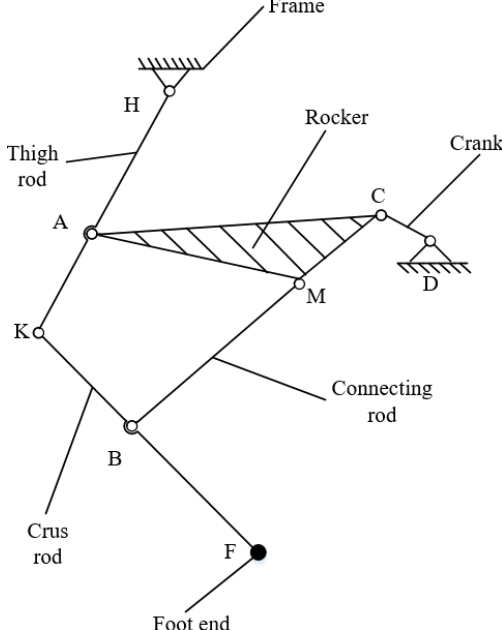
Figure 2. Structural diagram of the robot.